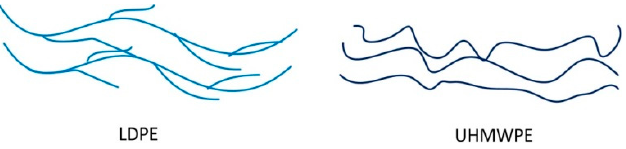
Figure 1. Schematic molecular structure representation of two types of extruded polyethylene.